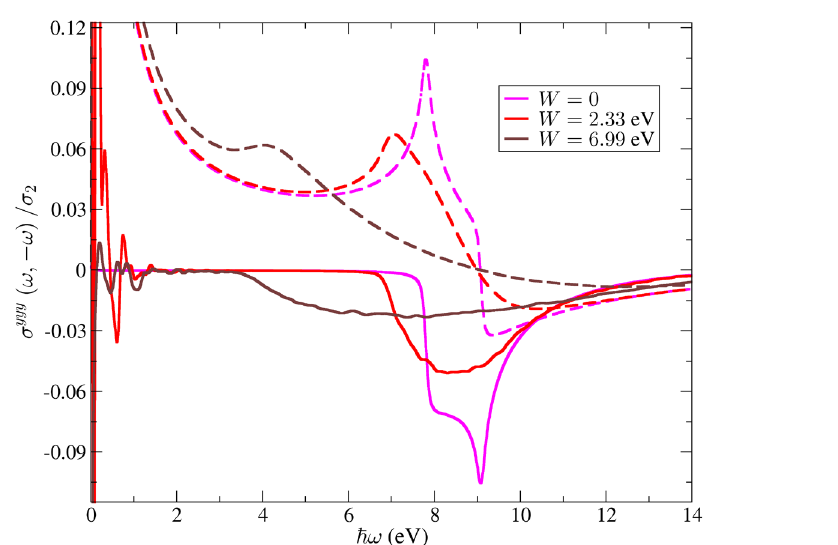
Figure 3. Photogalvanic effect for gapped Graphene in the presence of Anderson disorder of varying strength W and a broadening parameter of γ = 23 meV. The gap is ∆ = 7 . 8 eV, the Fermi energy is ε F = 0 eV and the lattice size is L = 2048 . Number of Chebyshev polynomials: M = 512 . The dashed lines represent the imaginary part of the